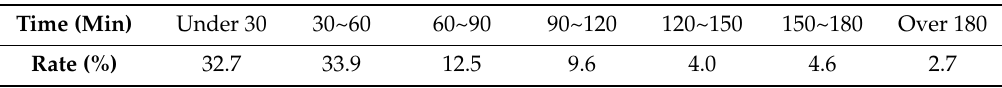
Table 17. Data regarding how long it takes to arrive home from the work in South Korea. Time (Min)